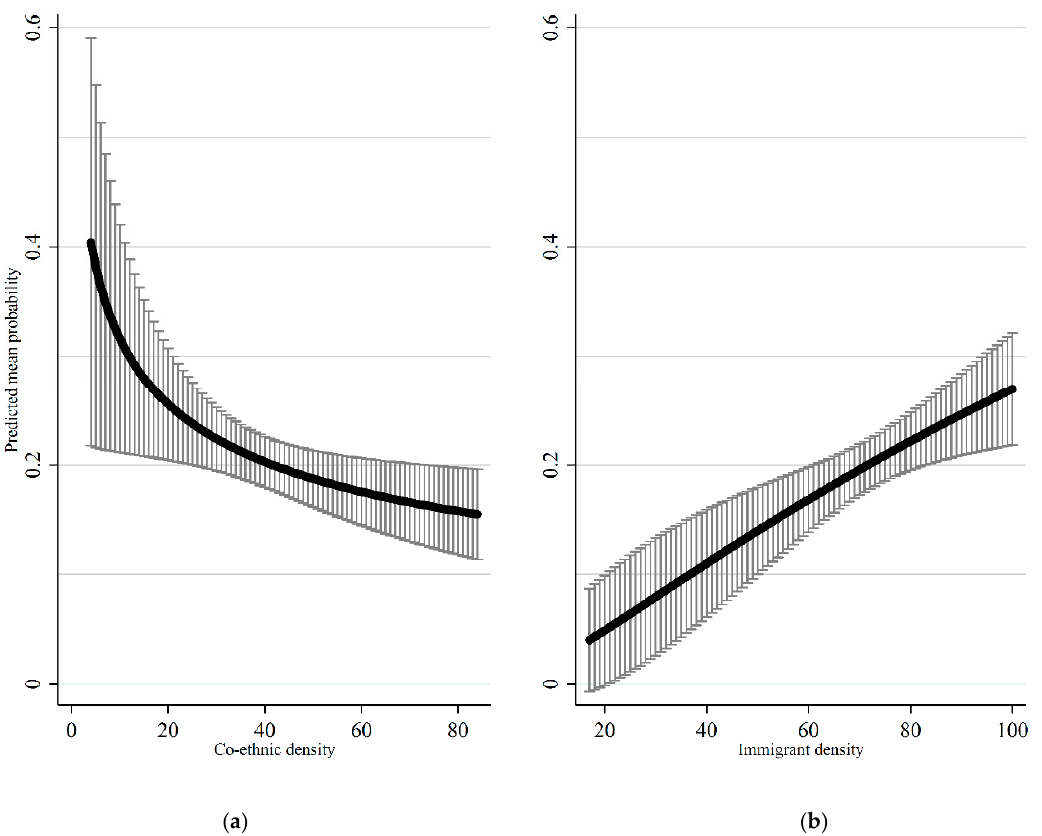
Figure 1. ( a ) Predicted mean probability of current smoking by co-ethnic density in school-class with 95% confidence intervals; ( b ) predicted mean probability of current smoking by immigrant density in class with 95% confidence intervals. Note: All other variables held at their observed values in the data.